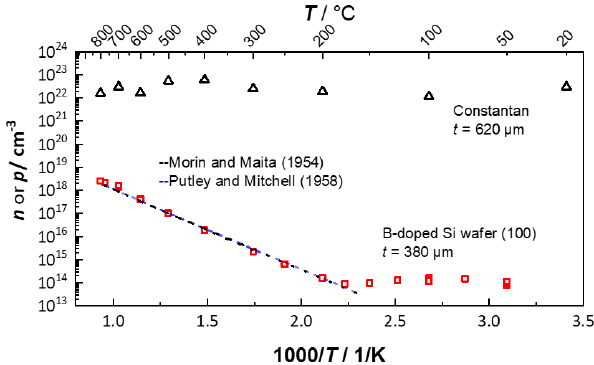
Figure 12. Arrhenius-like representation of the charge carrier den- sities of constantan ( n ) and a boron-doped Si wafer ( p ) up to 800 ◦ C. Additionally, the charge carrier concentration data from the intrinsic conductivity of silicon, as adapted from Morin and Maita (1954) and Putley and Mitchell (1958), are